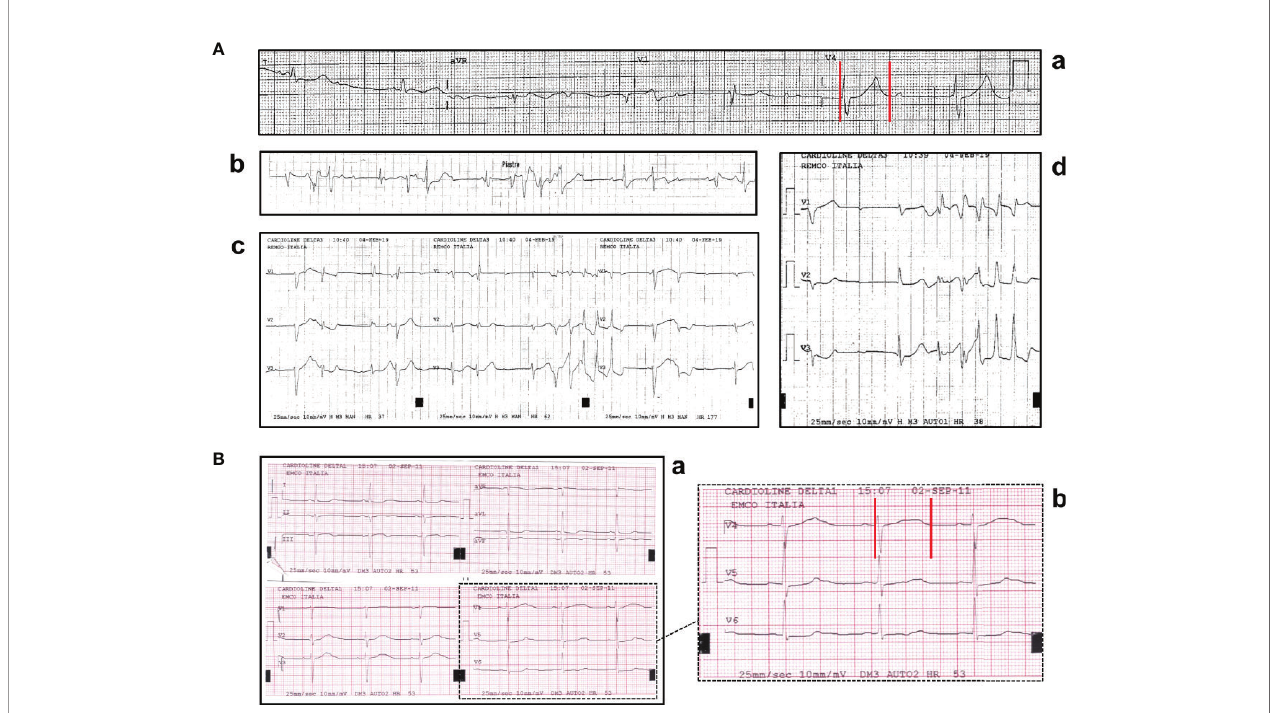
FIGURE 2 | (A) ECG fi ndings in patient 1: (a) QTc prolongation (530 ms); (b-d) recurrent episodes of self-terminating Torsades de Pointes. (B) ECG fi ndings in patient 2: sinus bradycardia with marked QTc prolongation (610 ms). Red vertical lines in lead V4 show the QT